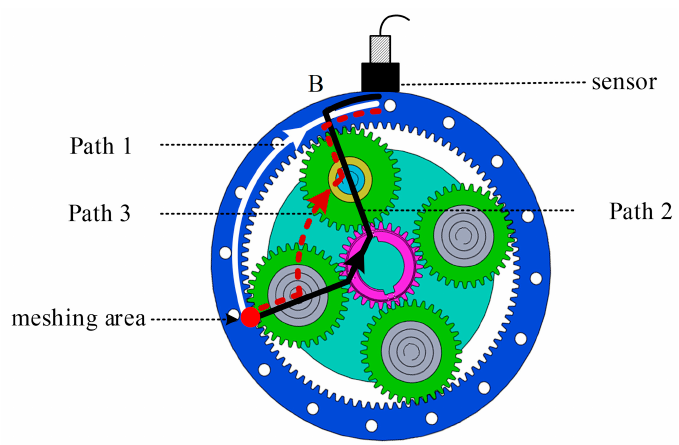
Figure 1. Signal transfer paths in planetary gearbox.